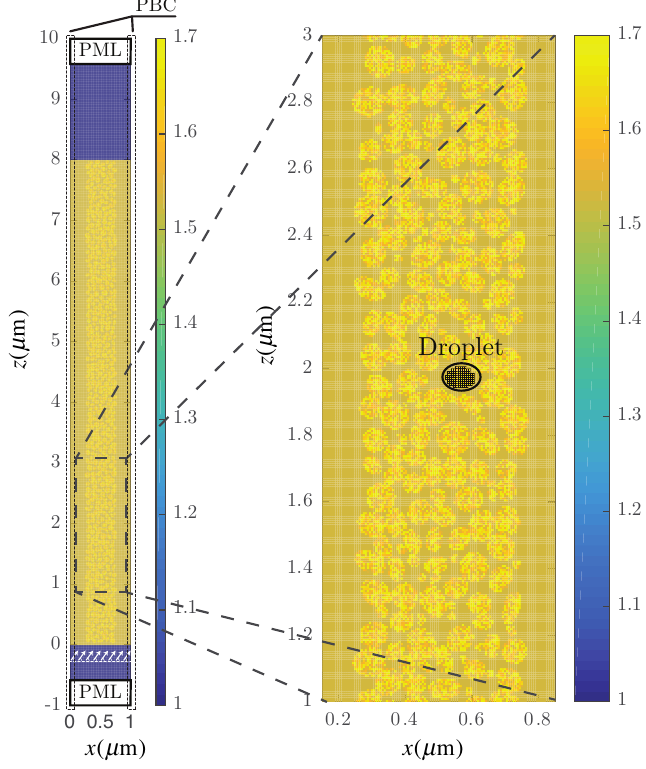
Figure 1. Geometry of the computational domain. The color map represents the refractive index of the